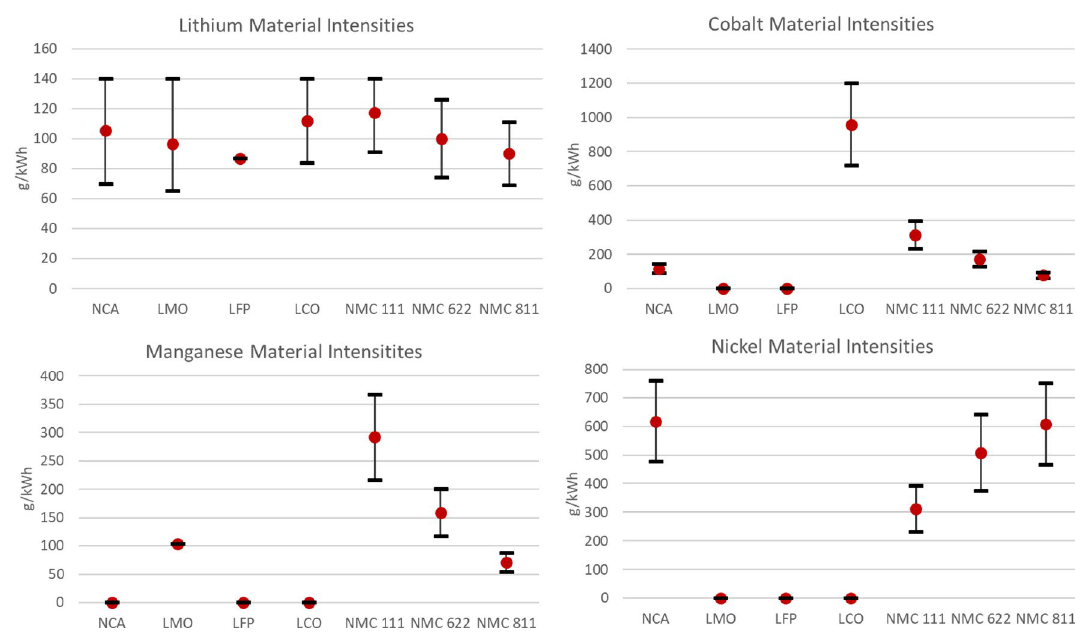
Fig. 5 Material intensities of lithium, cobalt, manganese, and nickel in seven different Li-ion battery chemistries. Note the differing y axis scales. Sources [7, 41,